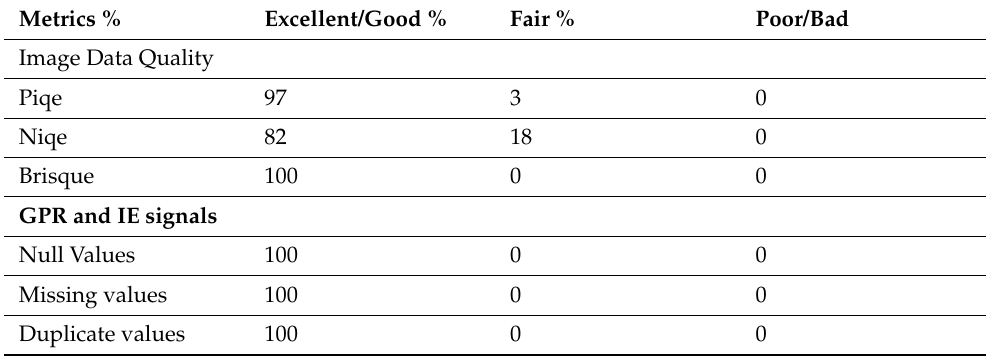
Table 8. NDE data quality